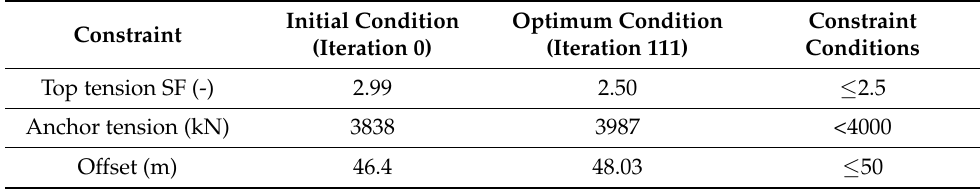
Table 12. The constraint results for case C.